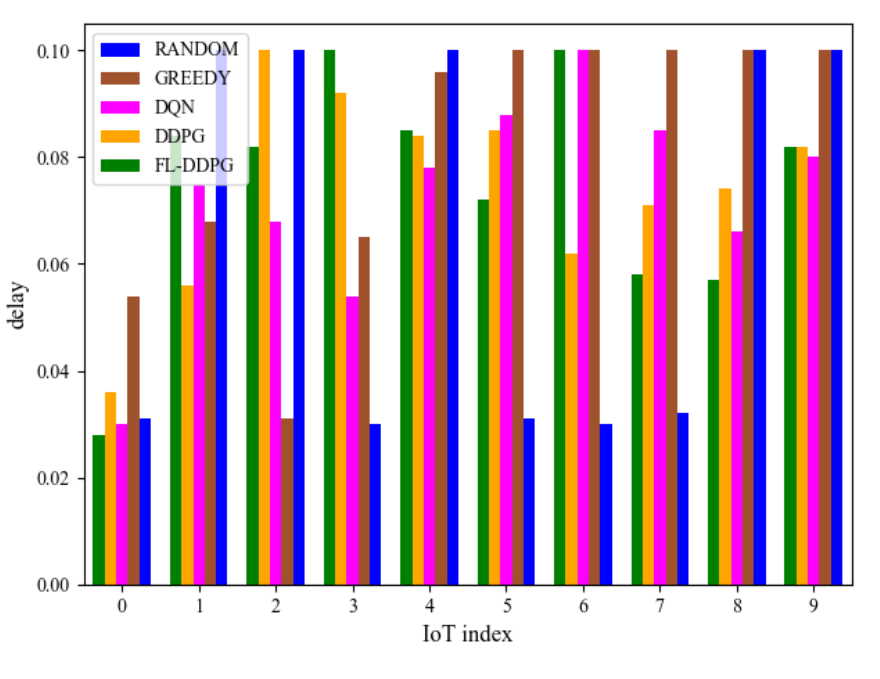
Figure 8. Delay of different algorithms.